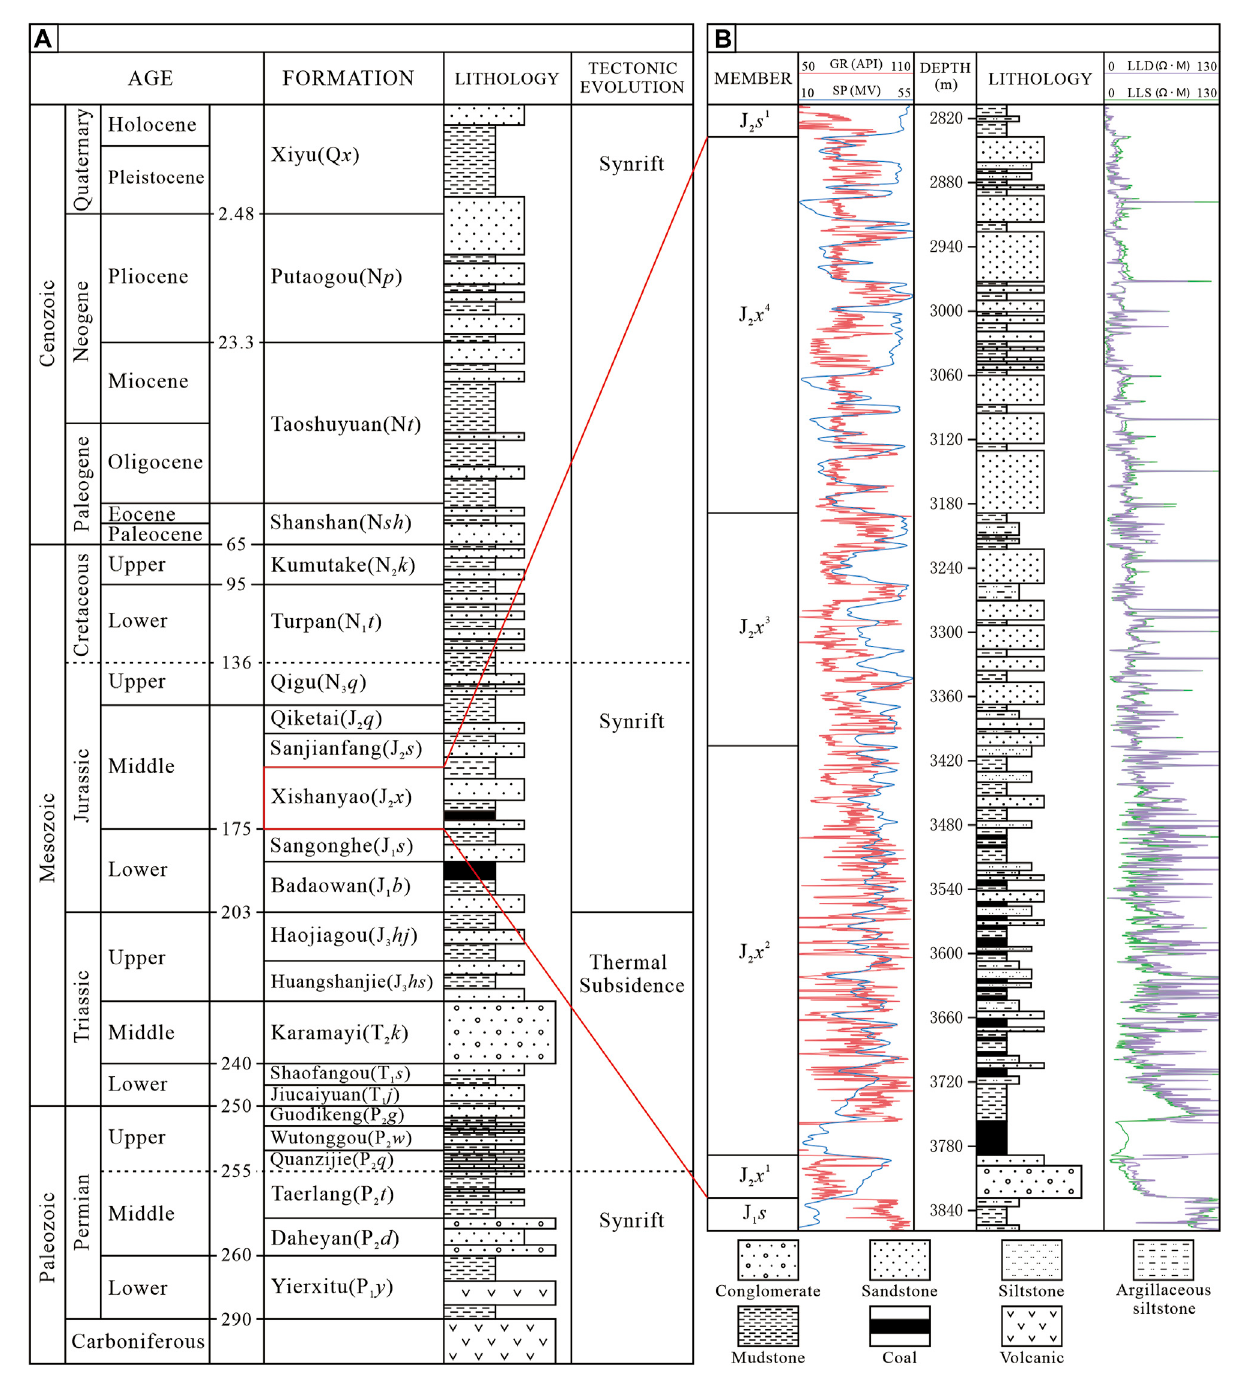
FIGURE 2 The generalized stratigraphy column of the Taibei Sag in the Turpan-Hami Basin with focused intervalsin this study. (A) The general in fi lling sedimentary successions of the Taibei Sag (Modi fi ed from Tian et al., 2017). (B) The subdivisions of the Xishanyao Formation.